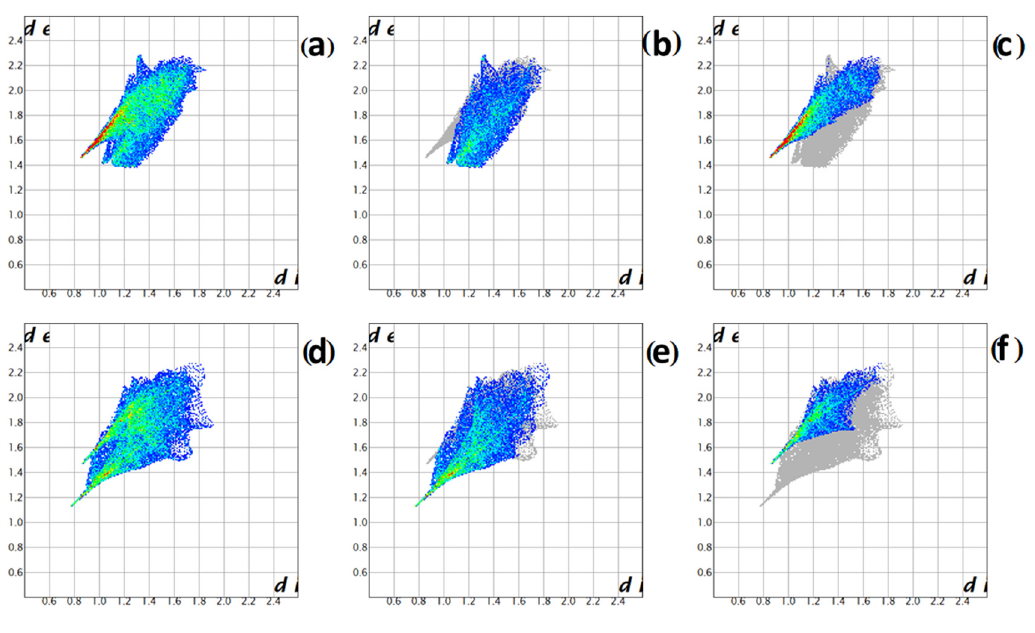
Figure 4. Fingerprint plots for the two hexaamminecobalt cations (( a ) intermolecular interactions of cation A , ( b ) N − H···O interactions of cation A , ( c ) N − H···Cl interactions of cation A , ( d ) intermolecular interactions of cation B , ( e ) N − H···O interactions of cation B , ( f ) N − H···Cl interactions of cation B ).